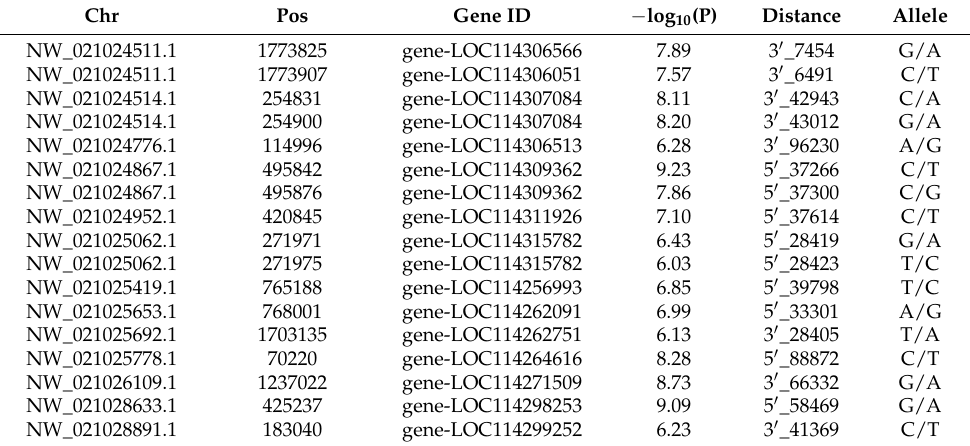
Table 3. Candidate genes related to